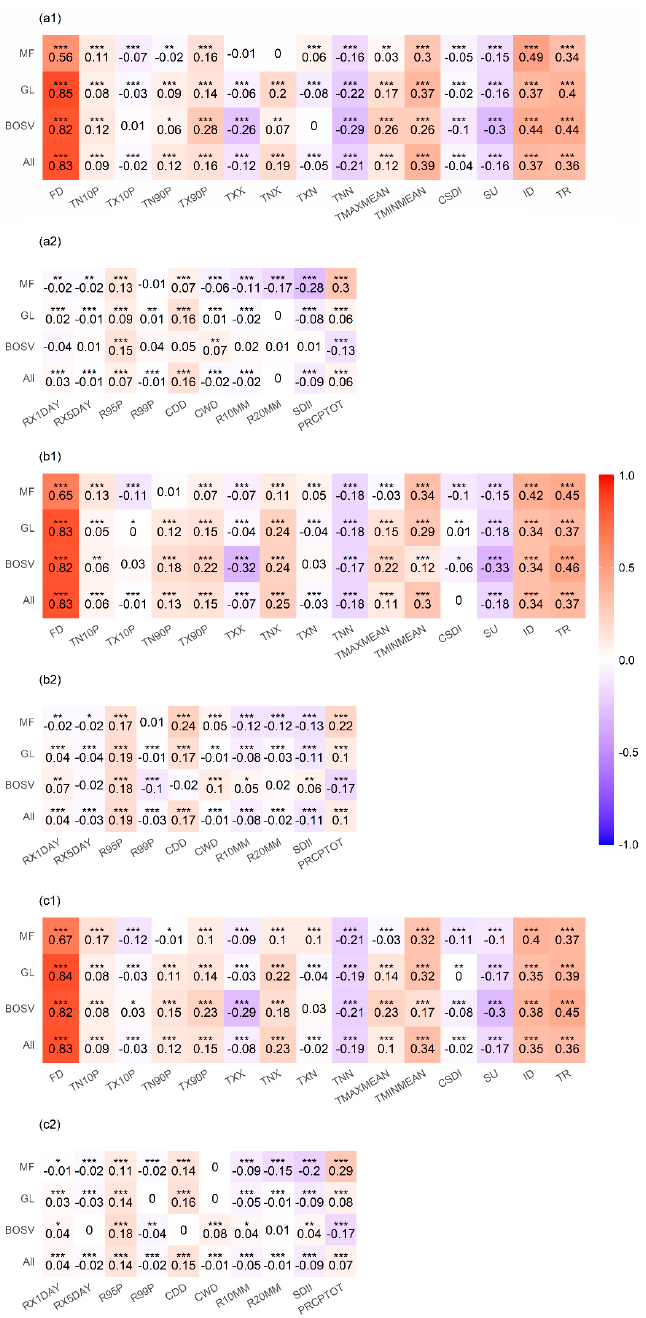
Figure 4. Partial correlation coefficients between the start of the growing season (SOS) and climate extremes indices (CEIs) for mixed forests (MF), grasslands (GL), barren or sparsely vegetated land (BOSV), and all three vegetation types (All). Figures ( a1 , a2 ) are the partial correlation coefficients between the extreme temperature indices, extreme precipitation indices, and SOS from 1982 to 1998, respectively. Similarly, Figures ( b1 , b2 , c1 , c2 ) are the partial correlation coefficients between the extreme temperature indices, extreme precipitation indices, and SOS during 1998–2015 and 1982–2015, respectively. * p < 0.05, ** p < 0.01, *** p <